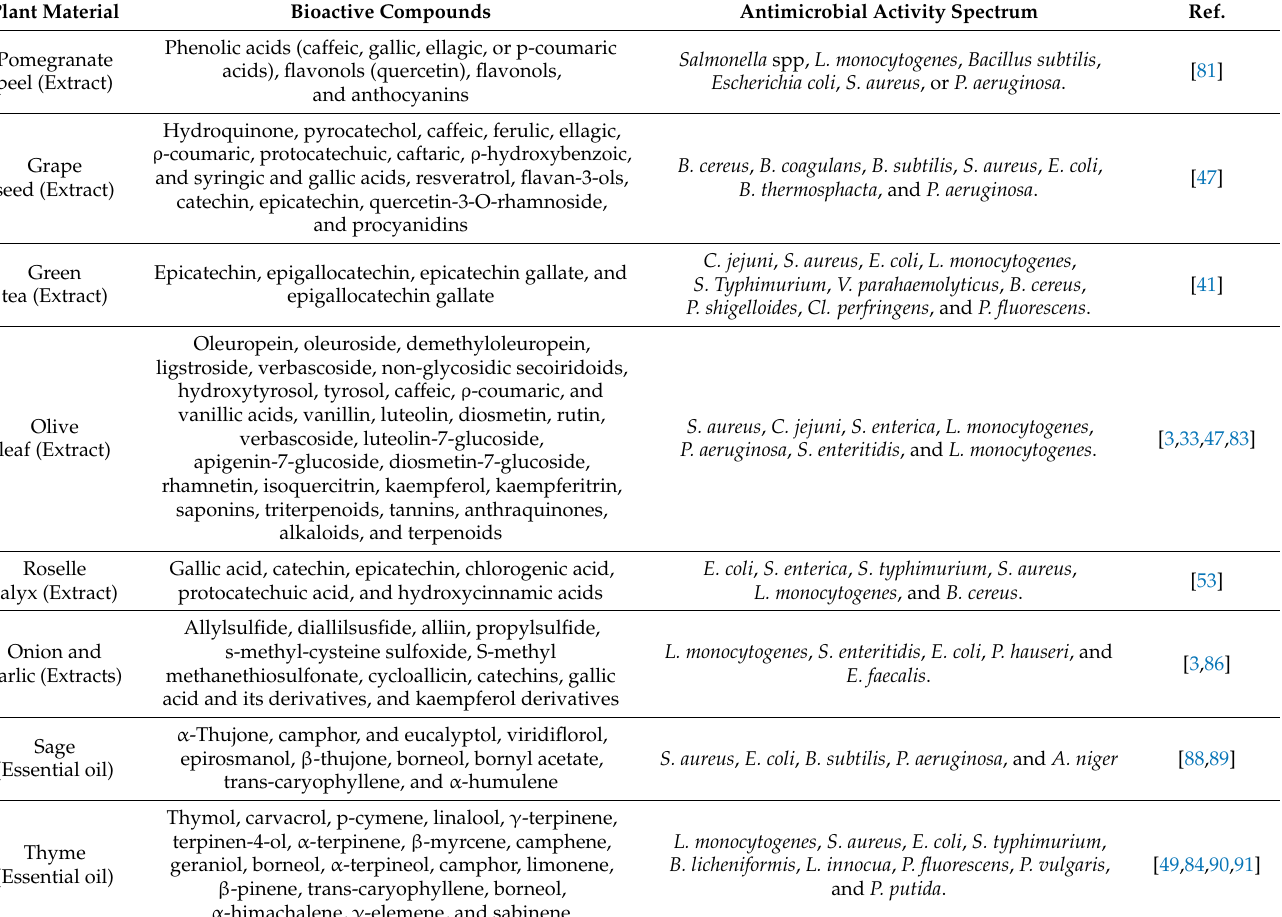
Table 2. Main bioactive compounds and antimicrobial activity spectrum of plant-derived extracts and essential